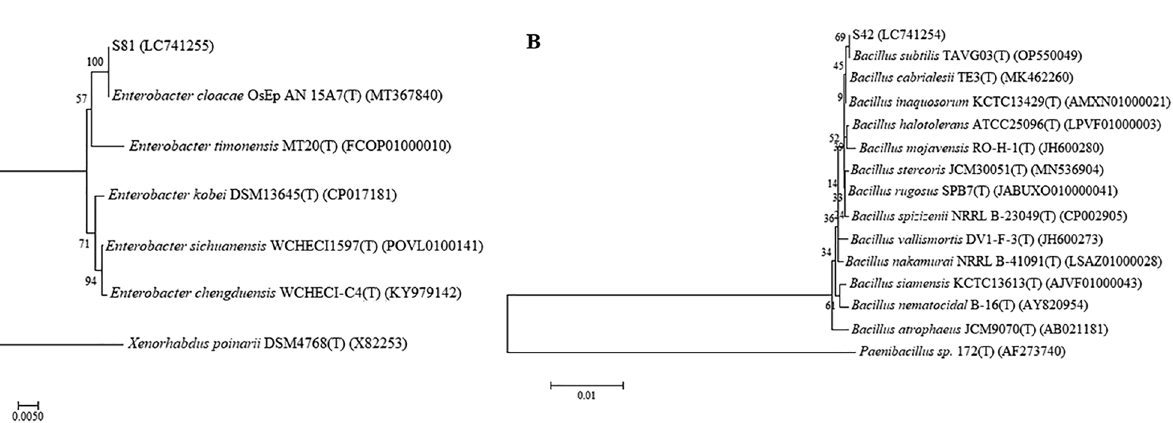
Figure 2. Phylogenetic tree based on 16S rDNA nucleotide sequences of S81 ( A ) and S42 ( B ) were constructed using the Neighbor-Joining with 1000 replicates of bootstrap. The bootstrap value is presented on the nodes. Maximum likelihood was used for computing the evolutionary